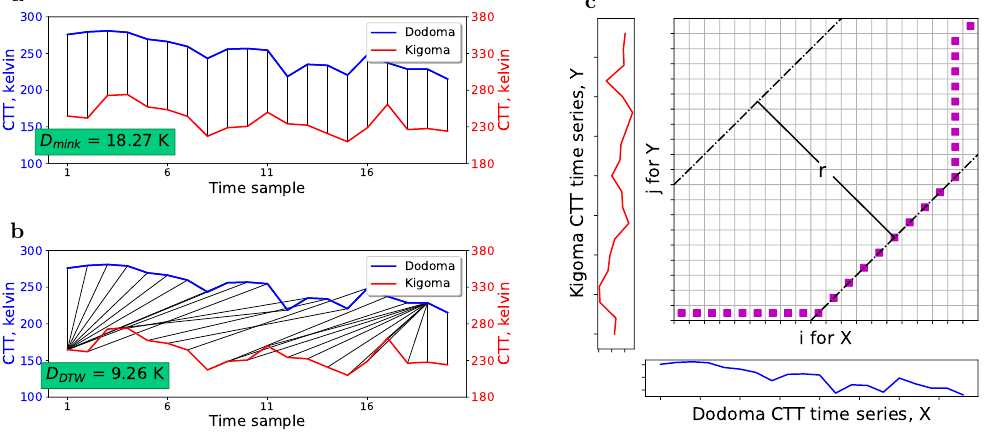
Figure 4. Illustration of Minkowski distance, dynamic time warping (DTW) distance and Sakoe–Chuba band using CTT time series at pixels of TMA stations Dodoma and Kigoma, with ( a ) Mikowski distance; ( b ) DTW distance and its optimal path along the time axis; and ( c ) Sakoe–Chuba band with bandwidth r =